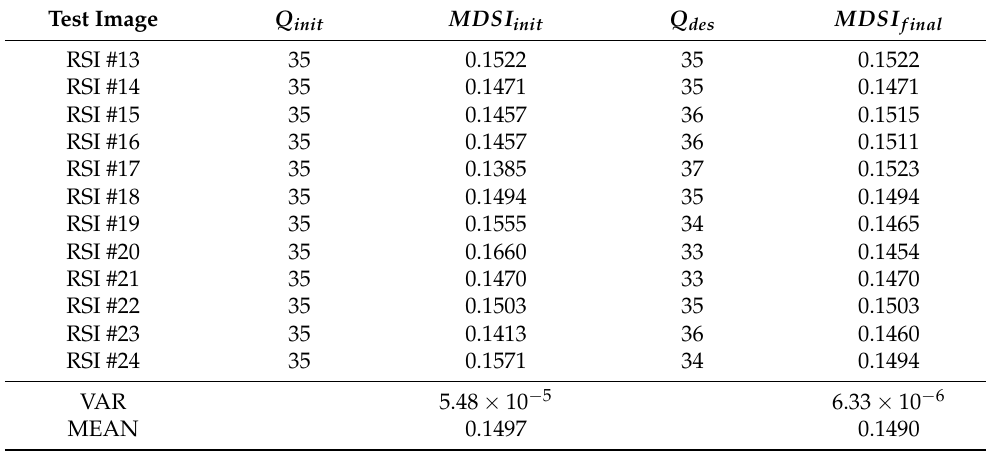
Table A8. The experimental data obtained for the test image set for the desired MDSI = 0.15.